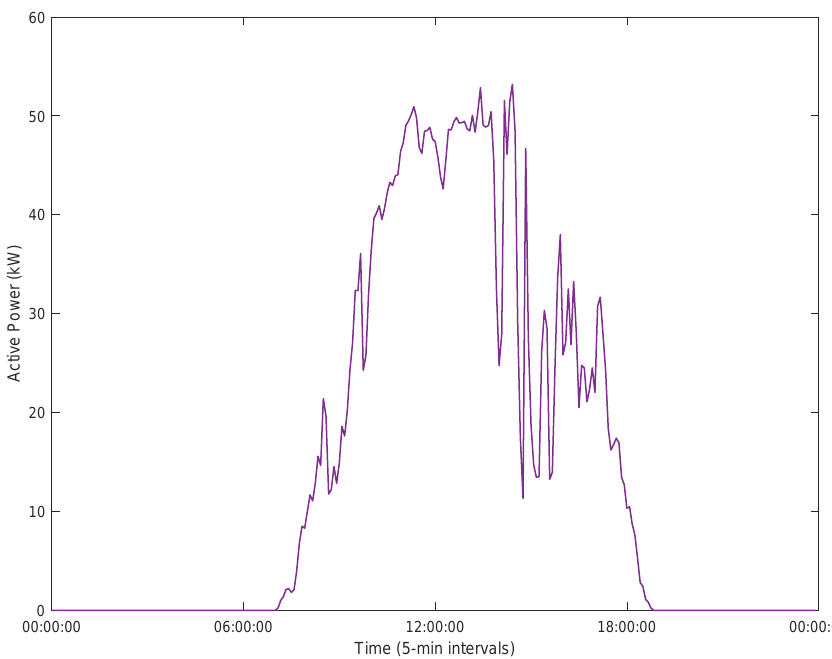
Figure 7. PV power generation units during a